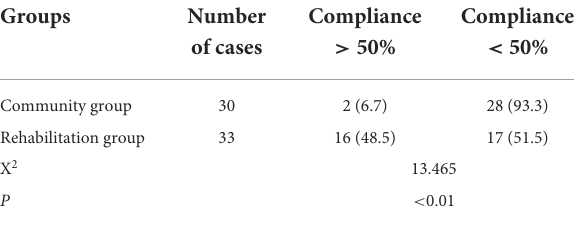
TABLE 5 Number of patients in compliance with cardiac rehabilitation (%).